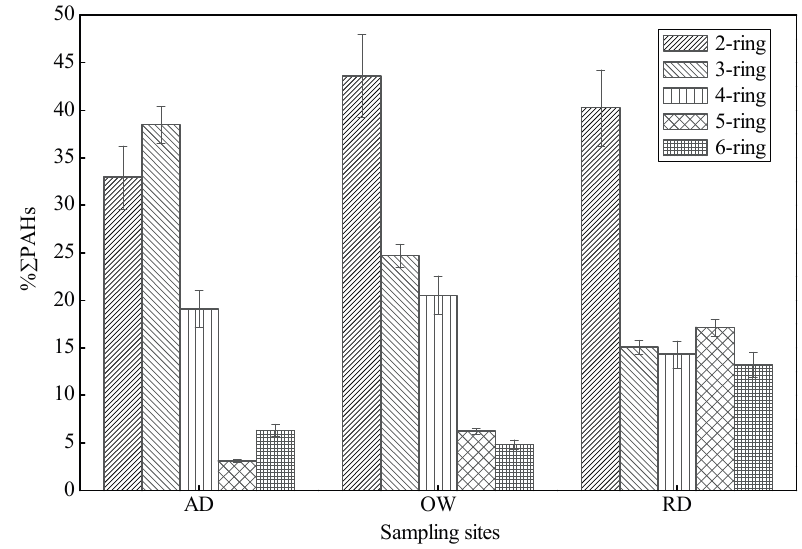
Figure 6. Composition profiles of PAHs in arable desert area (AD), oil producing and storage areas (OW), and residential area (RD) soil